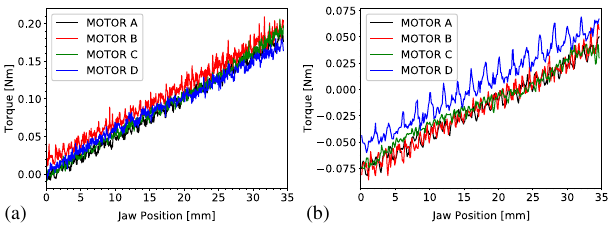
FIG. 5. Static and dynamic torque measurements for the four jaw motors. (a) Static torque and (b) Dynamic torque (IN to OUT).